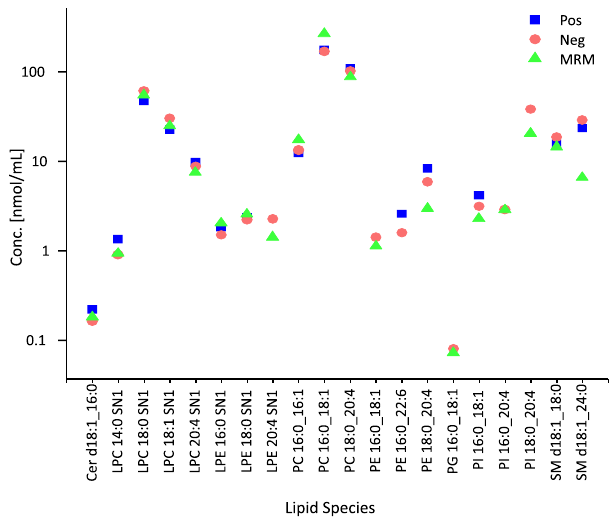
Fig. 6 | Comparison and cross-validation of quanti fi ed lipid concentrations. Comparisonofthequanti fi edlipidspeciesbetweenthepositiveandnegativemode 4-Dimensional(4D)lipidomics( n =32samplesineachmode)andmultiplereaction monitoring (MRM) ( n =10 measurements) analysis. Source data are provided as a Source data fi le and in Supplementary Data